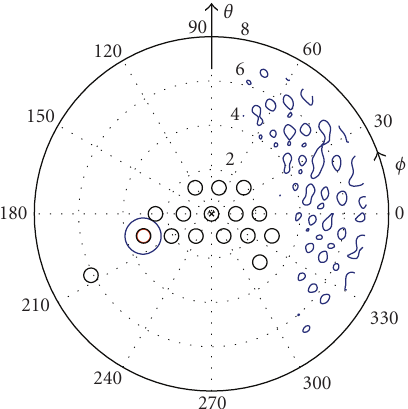
Figure 11: Array pattern for the configuration depicted in Figure 9. The beam is pointing at Europe edges. The red line represents the iso-level curves at 43.8 dBi, and the blue ones the iso-level curves at 20dBi. The black circles represent the interfering